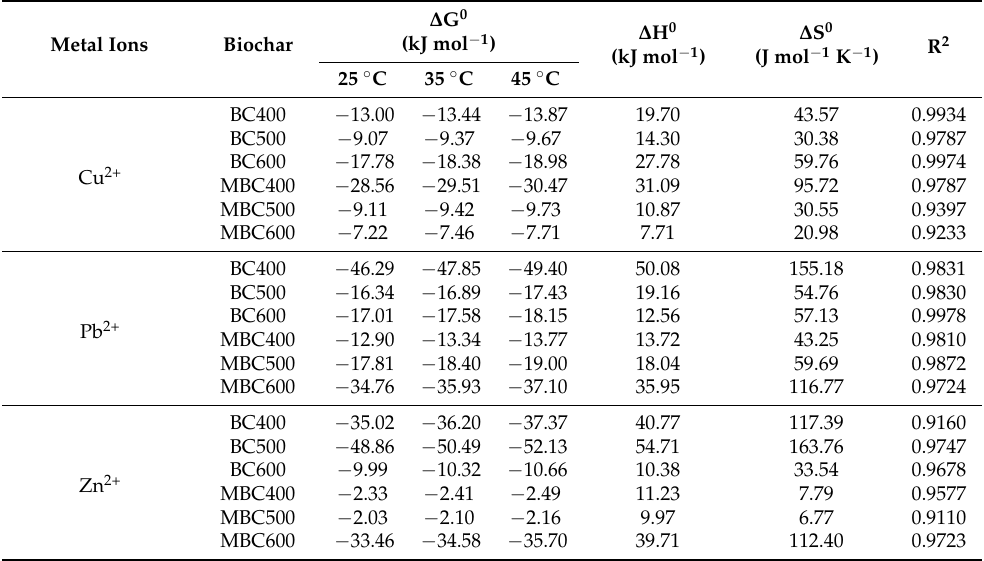
Table 1. Adsorption thermodynamic parameters for Cu 2+ , Pb 2+ , and Zn 2+ on biochars (BCs) and metallic biochars